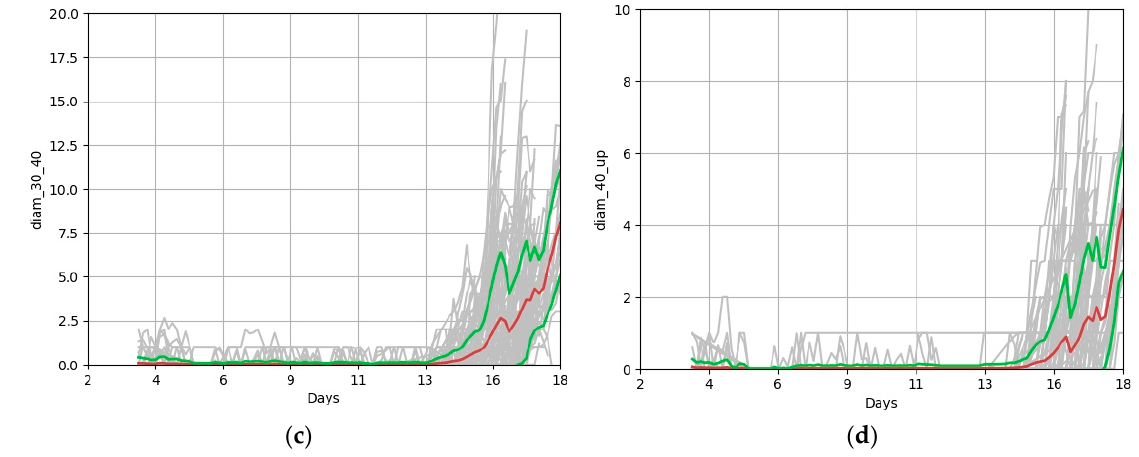
Figure A4. Number of mushrooms (pins) of diameter < 5 mm ( a ), 20–30 mm ( b ), 30–40 mm ( c ), > 40 mm ( d ). The brown line represents the medium value, the green line represents standard deviation.